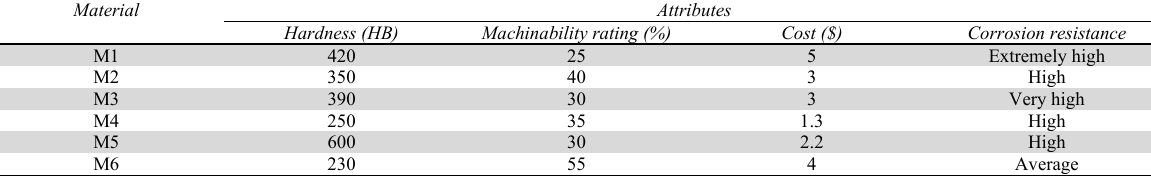
Data table for example 3 (Rao, 2007; Rao, 2013)